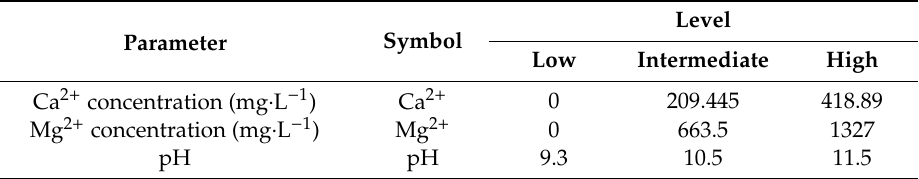
Table 3. Parameters and relative values used for setting the experimental